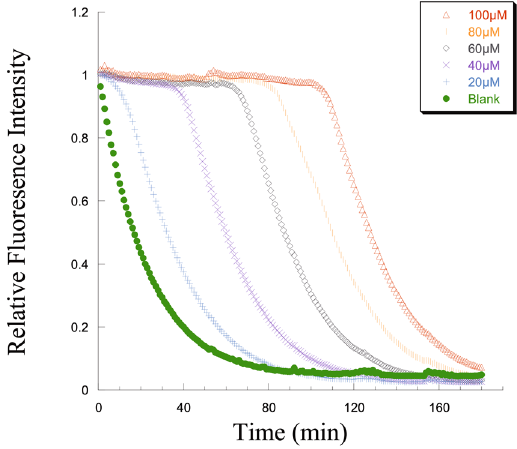
Figure 5. Fluorescence decay curve of fluorescein in the absence and presence of Trolox to determine Trolox’s radical scavenging capacity. The relative fluorescence intensity of fluorescein was diminished by the OH • radical reactive oxygen species. Trolox is a free radical scavenging compound that removes OH • groups from the solution and returns the fluorescence intensity of fluorescein in a dose dependent manner. The relative fluorescence intensity lasted for ~10, 50, 80, 100 and 120 min in presence of 20, 40, 60, 80, and 100 μΜ Trolox,